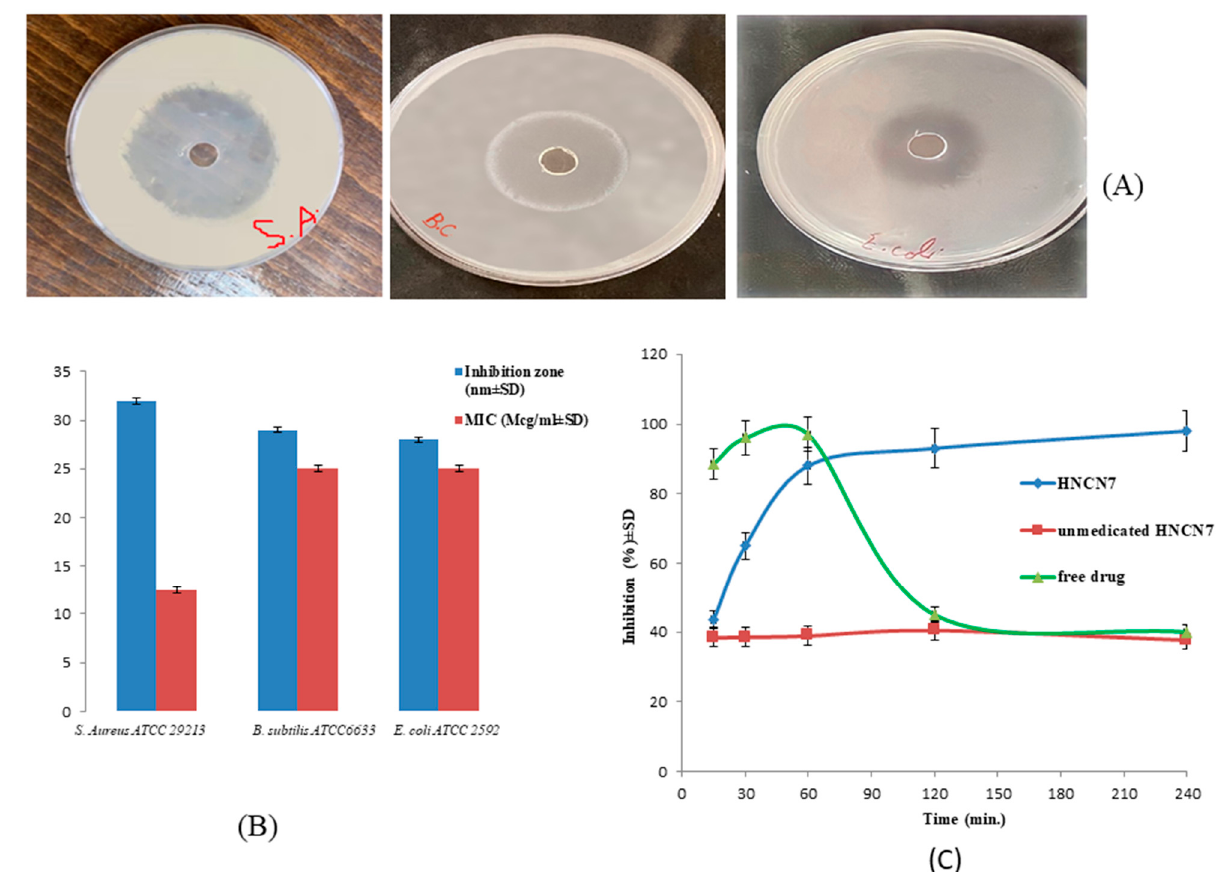
Figure 4. ( A ) The inhibition zones produced by OFX-loaded HNCN7 against Escherichia coli, Bacillus subtilis, and Staphylococcus aureus ( B ) The inhibition zones and the MICs produced by OFX-loaded HNCN7 against Escherichia coli , Bacillus subtilis , and Staphylococcus aureus and ( C ) In vitro time- dependent antibacterial assay for HNCN7, unmedicated HNCN7 (blank) and the free drug using S. aureus as test